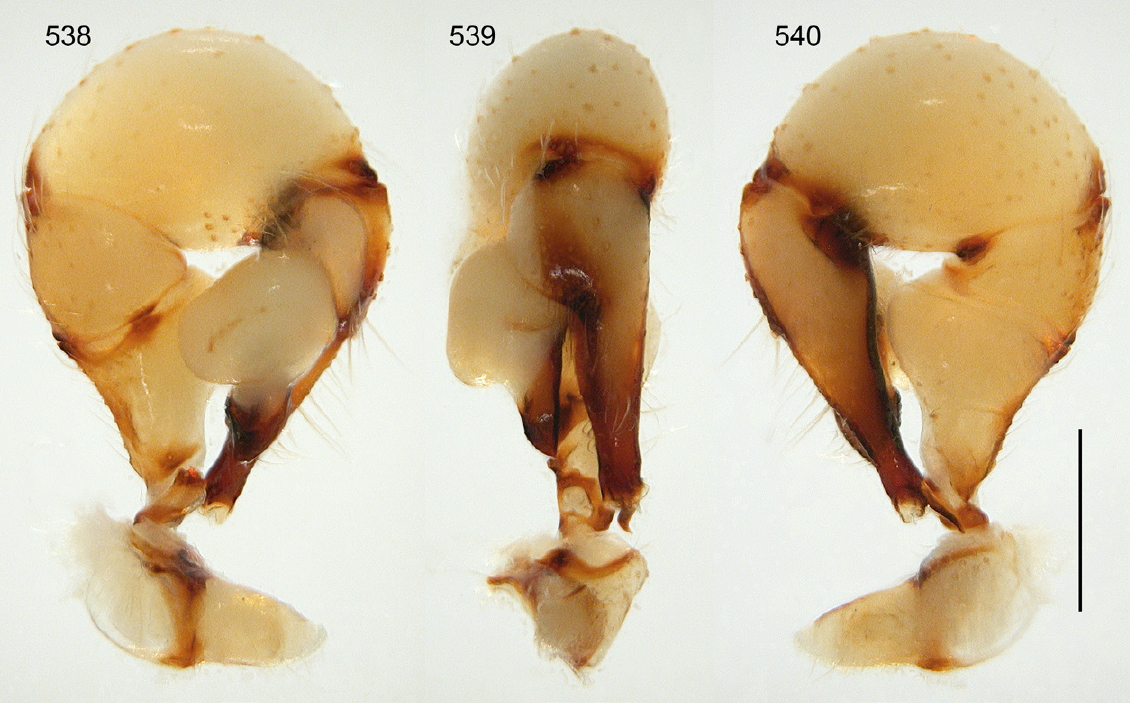
Figs 538–540. Crossopriza ibnsinai sp. nov.; male from Uzbekistan, near Dzhyra-Kuduk (SZMN); mirror images of right palp, prolateral, dorsal, and retrolateral views. Scale bar = 0.5